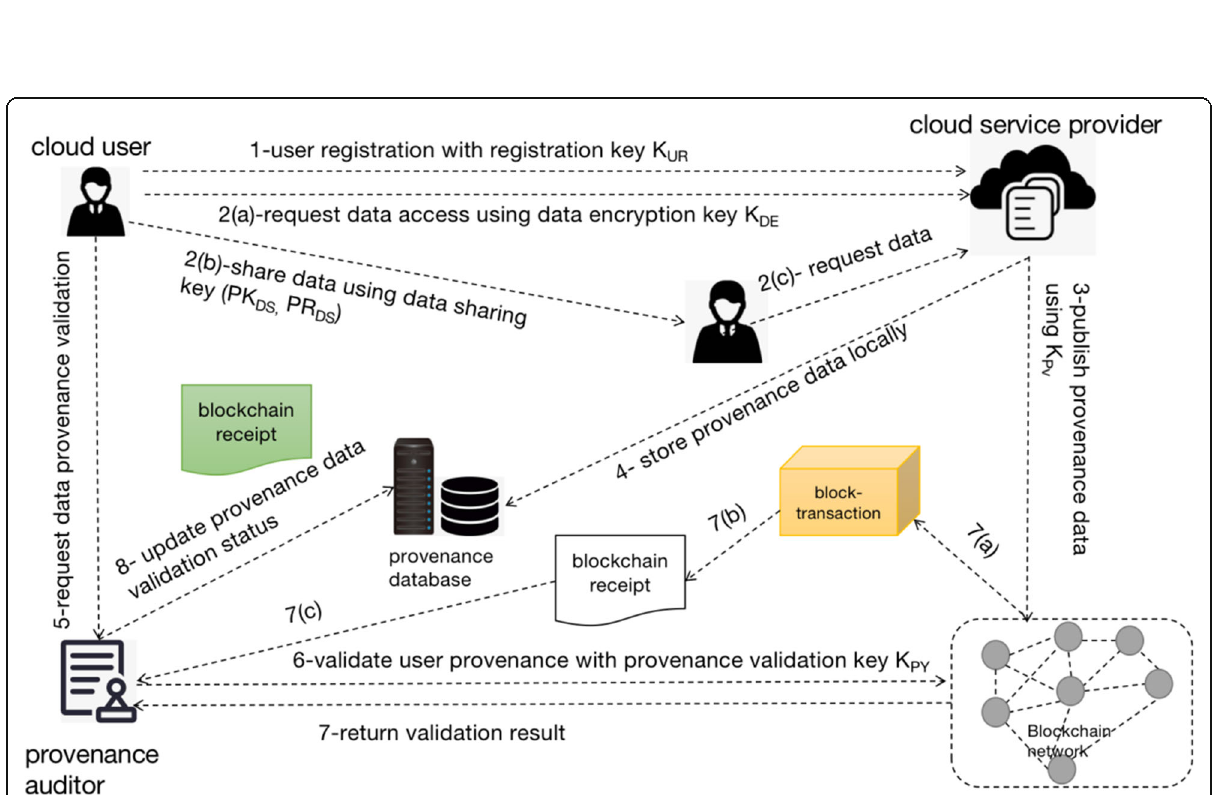
Fig. 15 System interaction model of ProvChain extended version of